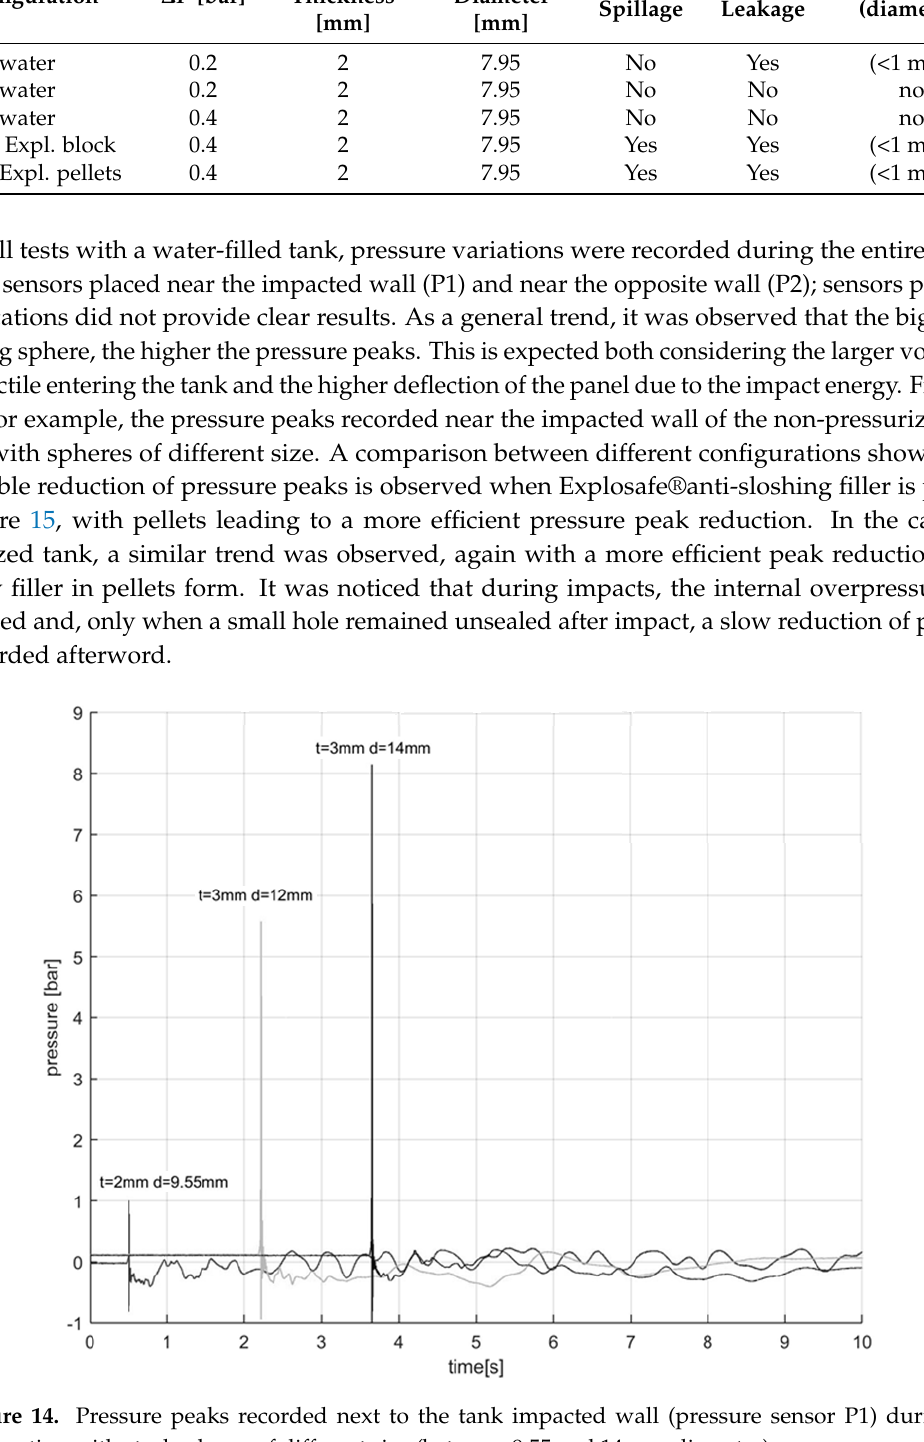
Figure 15. Pressure peaks recorded in the tank far from the impacted wall (pressure sensor P2) with different configurations ( t = 3 mm, steel sphere 14 mm). 4. Conclusions In this work, the self-healing behavior of an ionomeric system was explored in view of safety-related aeronautical applications. Ballistic tests were conducted in a variety of aging and